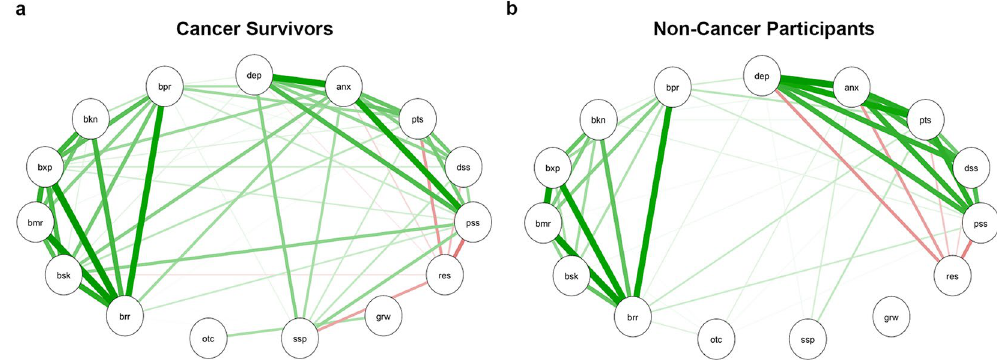
Figure 1. Correlation network of psychosocial assessments in ( a ) cancer survivors and ( b ) non-cancer participants groups. Only significant correlations are shown as determined by qgraph. Green lines: positive correlations; red lines: negative correlations. Line thickness shows the strength of the correlation. All comparisons shown are statistically significant. P < 0.05. brr : barriers to care – total; bsk : barriers to care – skills; bmr : barriers to care – marginalization; bxp : barriers to care – expectations; bkn : barriers to care – knowledge and beliefs; bpr : barriers to care – pragmatics; dep : depressive symptomatology; anx : anxiety symptomatology; pts : post-traumatic stress disorder symptoms; dst : distress; prc : perceived stress; rsl : resilience; grw : post- traumatic growth; scs : perceived social support; otc : natural disaster